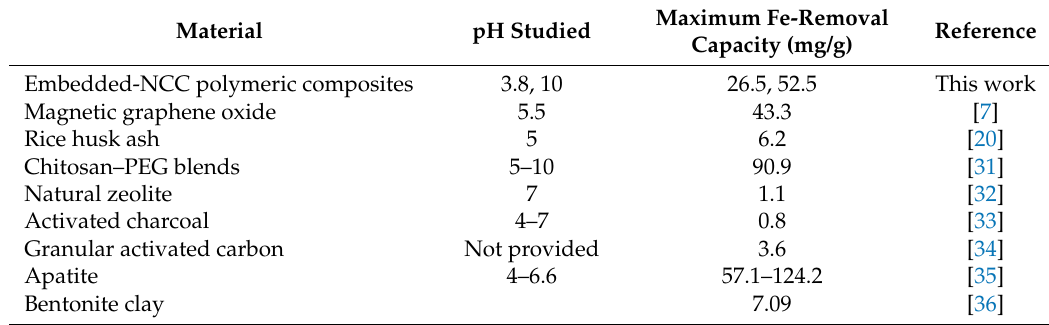
Table 3. Summary of iron-chelating adsorbents evaluated in